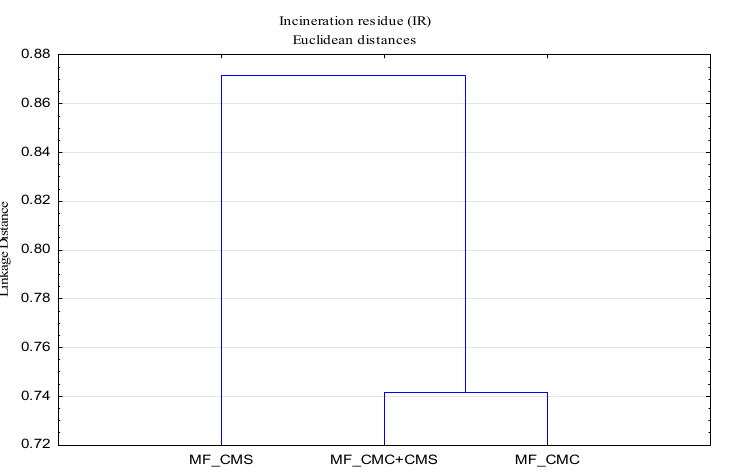
Figure 2. Dendrogram of incineration residue of modified cotton fabric (MF) as a function of surface modifiers in hard water.